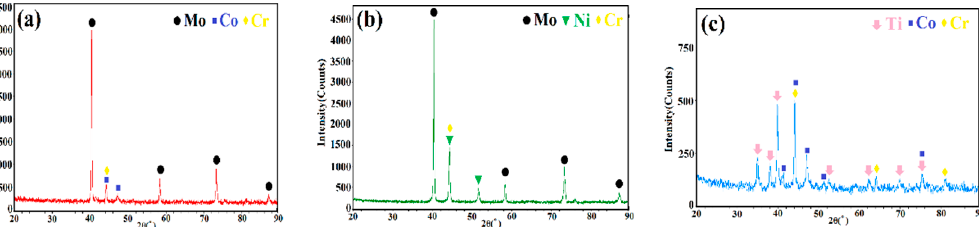
Figure 8. The X-ray diffraction (XRD) patterns of mixture powders ( a ) Mo–B–Co–Cr, ( b ) Mo–B–Ni– Cr, and ( c ) Ti–B–Co–Cr.